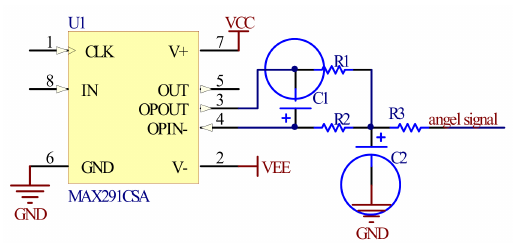
Figure 7. The second-order Butterworth low-pass